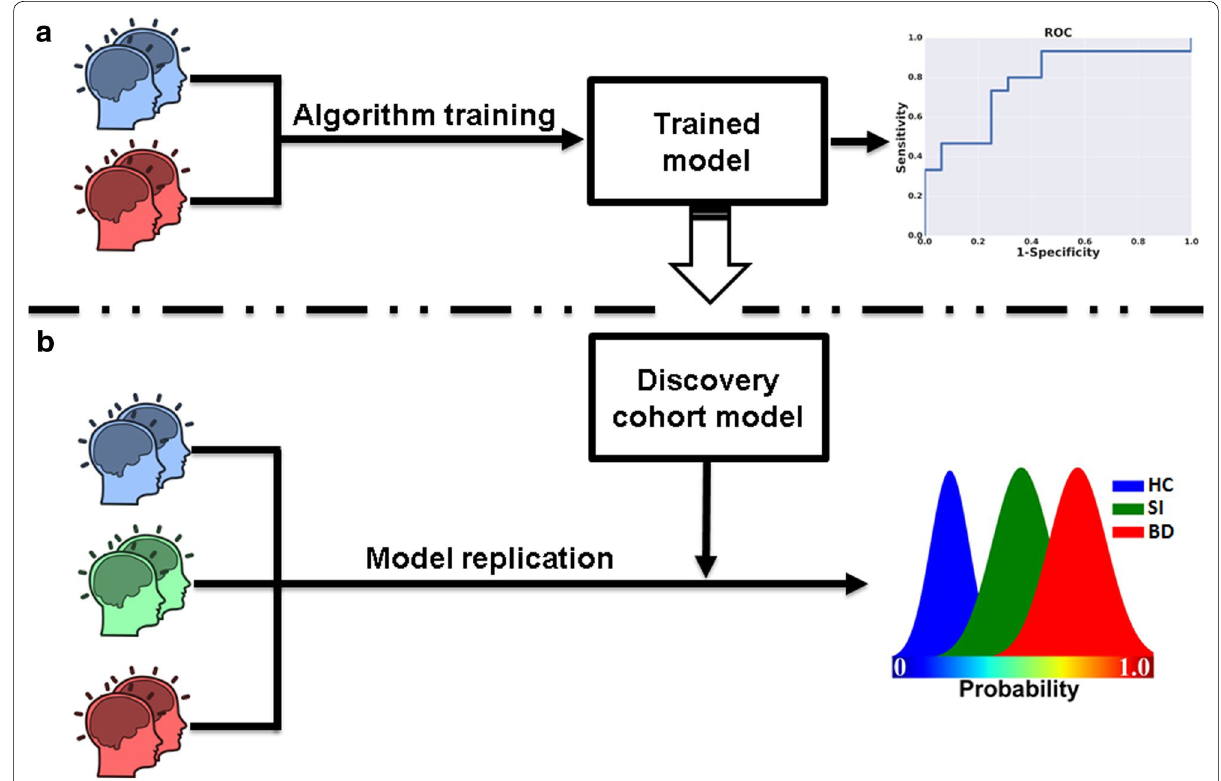
Fig. 1 A flow diagram showing the signature discovery and replication